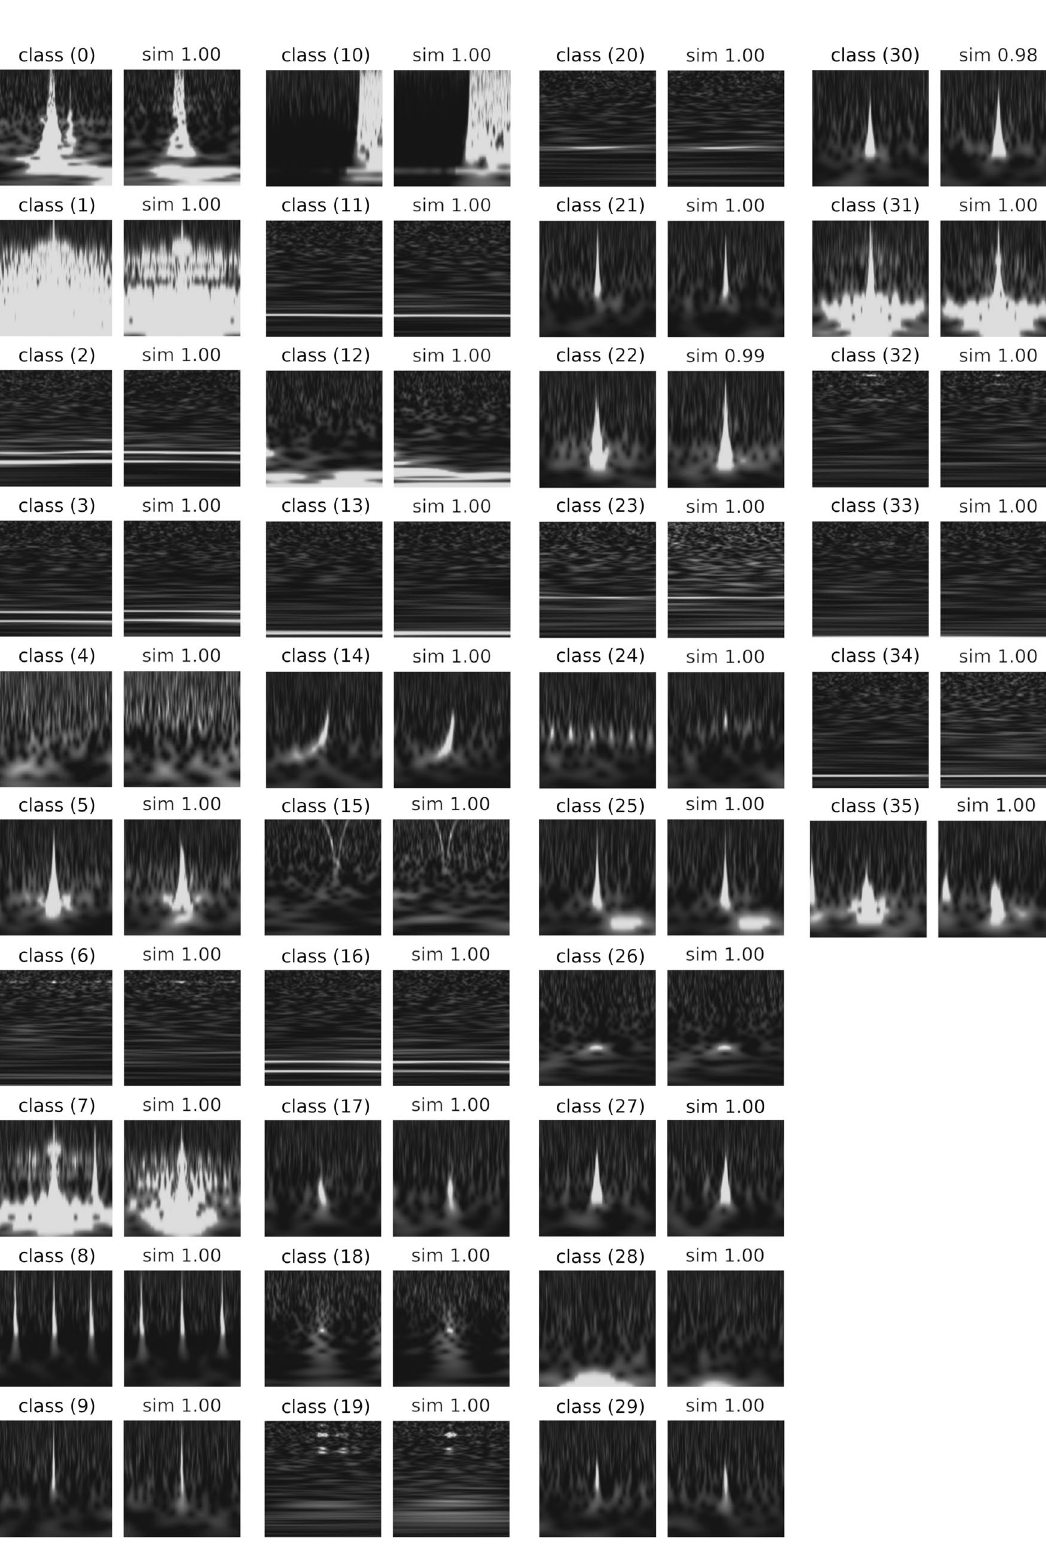
Figure 3. The representative and similar images in all the classes were classified using unsupervised learning. This representative image which is denoted by i in the image is randomly selected from a class i ∈ c = { 0, . . . , 35 } , and its most similar image is to the right of a representative image in class ( i ). The cosine similarity to the representative image in class ( i ) is shown at the top of the